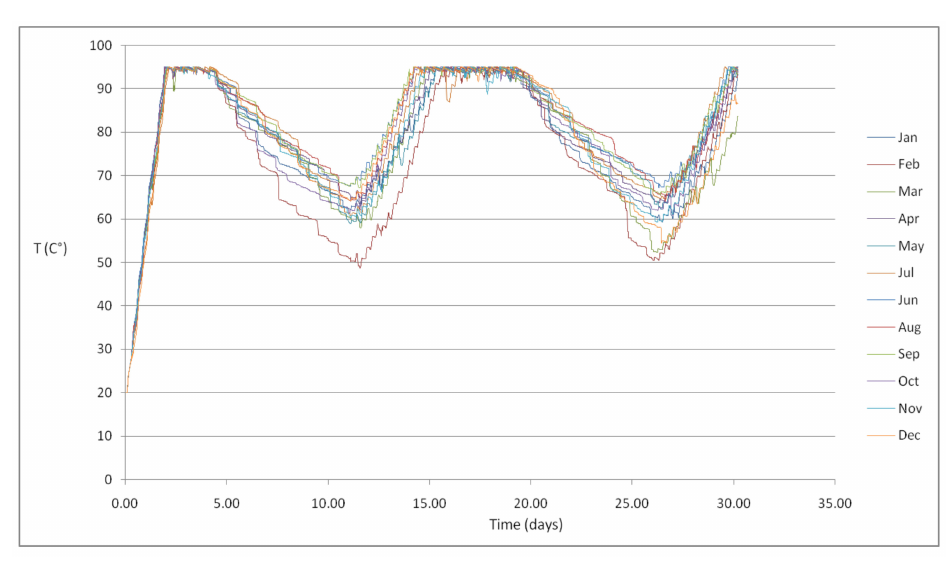
Figure 12. The temperature in the 1.5 m 3 HWT (Case 1b).